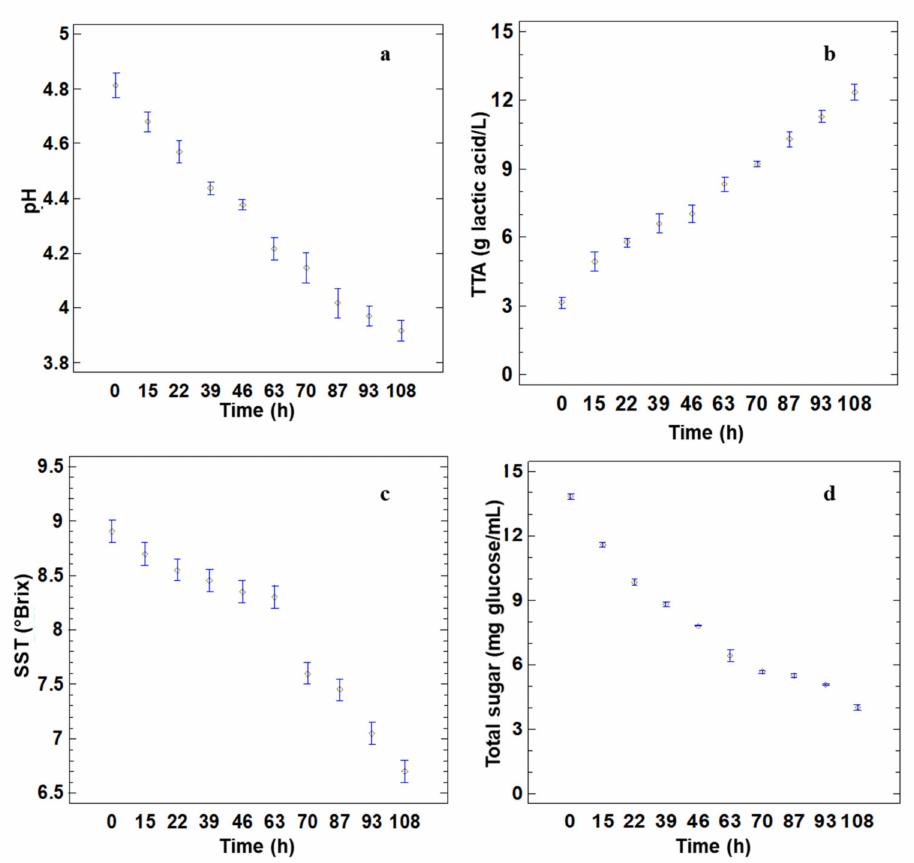
Figure 2. Analysis of pH ( a ), total soluble solids ( b ), total titratable acidity ( c ) and total sugar of fermented liquor from shrimp waste ( d